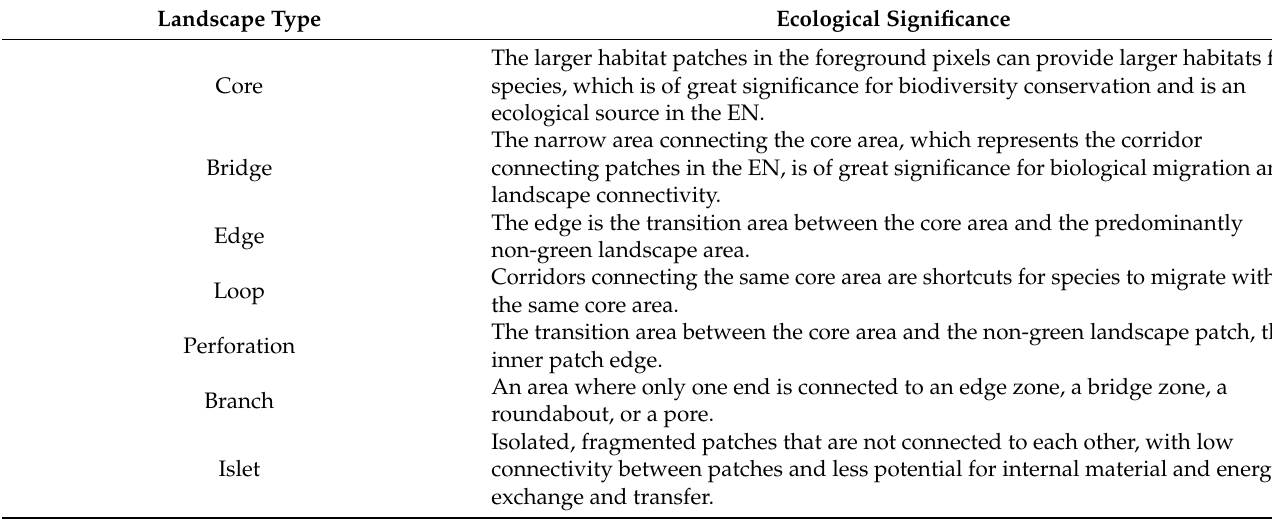
Figure 2. Status of land use in the study area. Table 2. Definition of landscape type based on